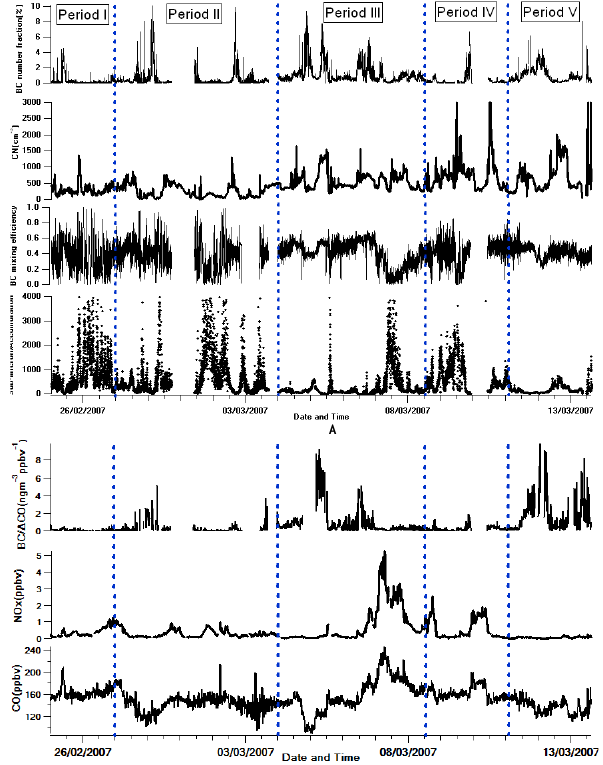
Fig. 6. Fig. 6. (A) Time series of aerosol properties during the entire ex- periment with the classified periods separated by dotted lines, from bottom to top: numerical ratio of sub-micron/accumulation mode particles as measured by the SP2; BC mixing efficiency; CN con- centration measured by the CPC; rBC number fraction within the population of sub-micron aerosols. (B) Time series of trace gases, from bottom to top: NO x volume mixing ratio (ppbv); CO volume mixing ratio (ppbv); BC/ 1 CO (ng m − 3 ppbv − 1 )